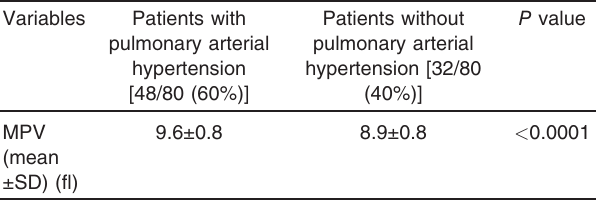
Table 7 Evaluation of mean platelet volume between patients with and without pulmonary arterial hypertension